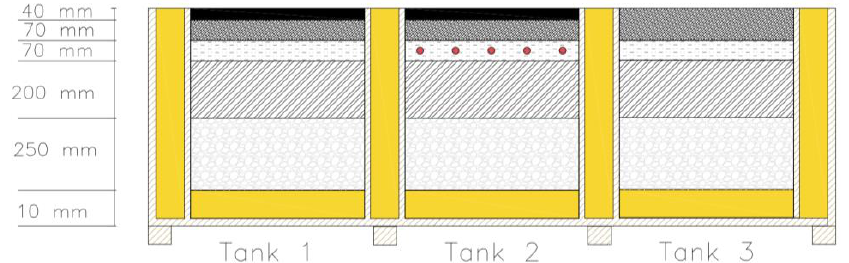
Figure 2. Experimental set-up schema geometrical configuration.